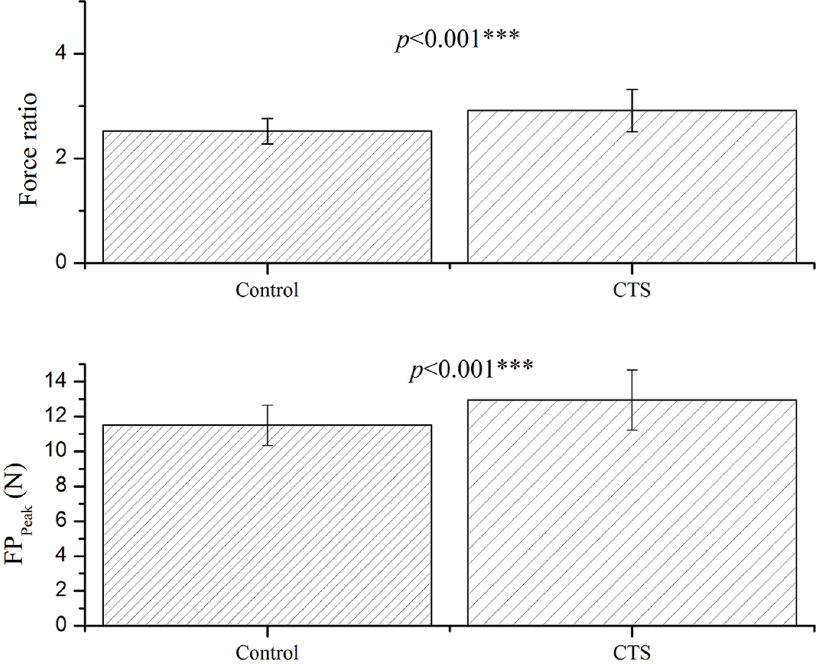
Figure 2. Mean ( 6 SD) of force ratio (upper) and FP Peak (lower) for CTS and healthy groups. Statistical differences were observed in both the force ratio and FP peak between CTS and control groups. (Statistical analysis method: mixed effect model; the level of significance was set at p # 0.05).